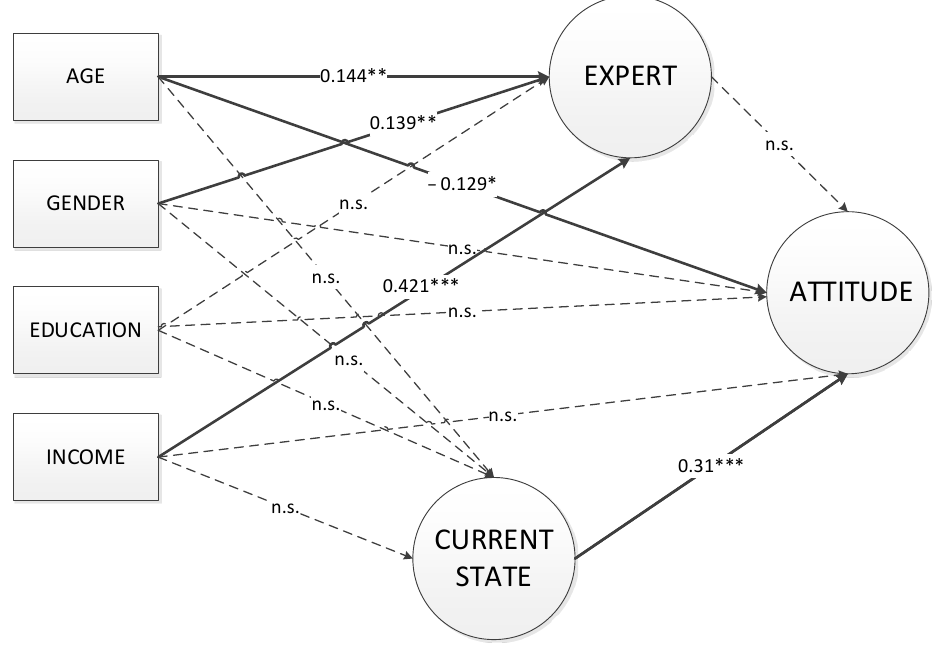
Figure 4. Estimated parameters along with corresponding statistical significance (Model C). * pa- rameter is significant at the 10% significance level. ** parameter is significant at the 5% significance level. *** parameter is significant at the 1% significance level. n.s.: non-significant.